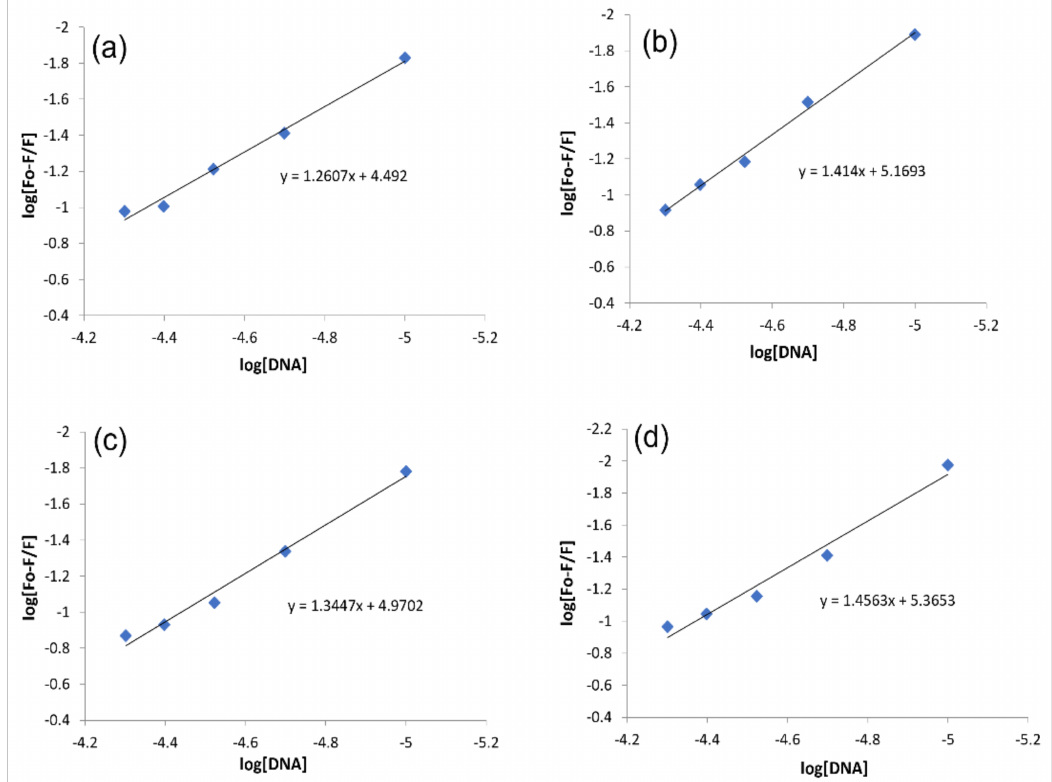
Figure 9. Graphs for the calculations of the binding constant and binding site size using Equation (3) for compound–DNA complex. ( a ) IST-01–DNA, ( b ) IST-02–DNA, ( c ) IST-03–DNA, ( d )